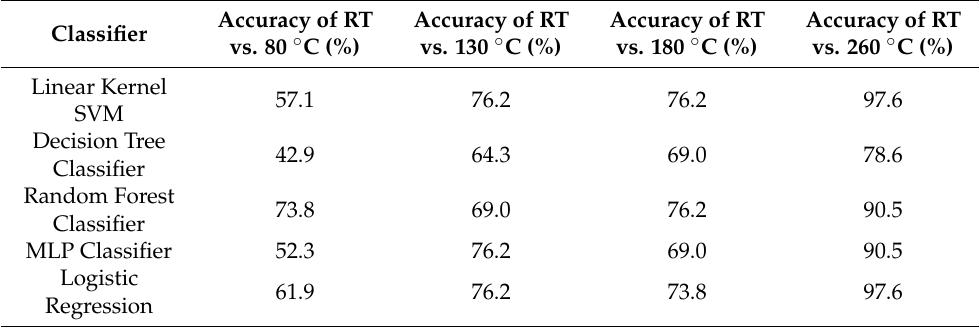
Table 4. Accuracy of array A of room temperature vs. different heating temperatures.